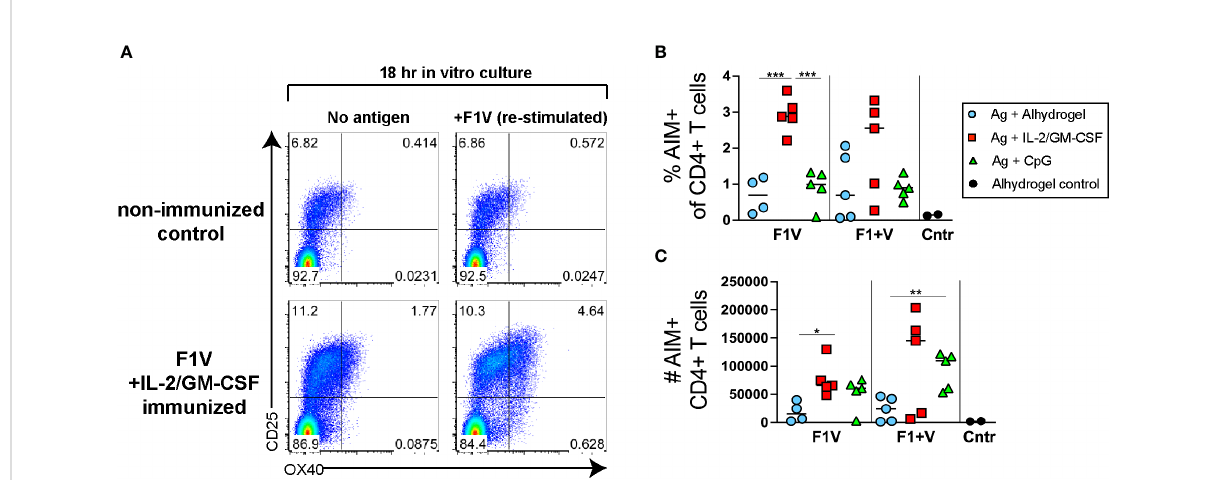
FIGURE 3 Plague antigen F1V-speci fi c CD4+ T cells as detected by activation-induced marker (AIM) assay. Cells from the draining lymph nodes 7 days post-immunization from immunized mice were cultured for 18 hours in the presence or absence of recombinant F1V antigen. Cells were then stained for surface markers and evaluated for antigen-induced upregulation of both OX40 and CD25. The frequency of speci fi c AIM+ cells (% AIM+ of CD4+ T cells shown in Figure 2B) was calculated as the frequency of CD4+B220- T cells that speci fi cally express both OX40 and CD25 (OX40+CD25+ double-positive population in upper right quadrant) cells following 18 hours of culture in the presence of F1V antigen minus the background frequency of OX40+CD25+ cells from the same sample following 18 hour culture in the absence of antigen. (A) Representative fl ow cytometry analysis of OX40 and CD25 expression by CD4+ gated T cells, of a control mouse (injected with alhydrogel but not immunized with antigen) and a F1V + IL-2/GM-CSF cytokine immunized mouse. (B) Chart shows the percent AIM+ of CD4+ T cells in the dLNs, which is the frequency of cells that are OX40+CD25+ cells in the F1V-restimulated minus the no-antigen culture for each individual sample. (C) Chart shows the number of AIM+ F1V-speci fi c OX40+CD25+ CD4+ T cells in the dLN. n=5 per group per experiment at each time point. Statistically